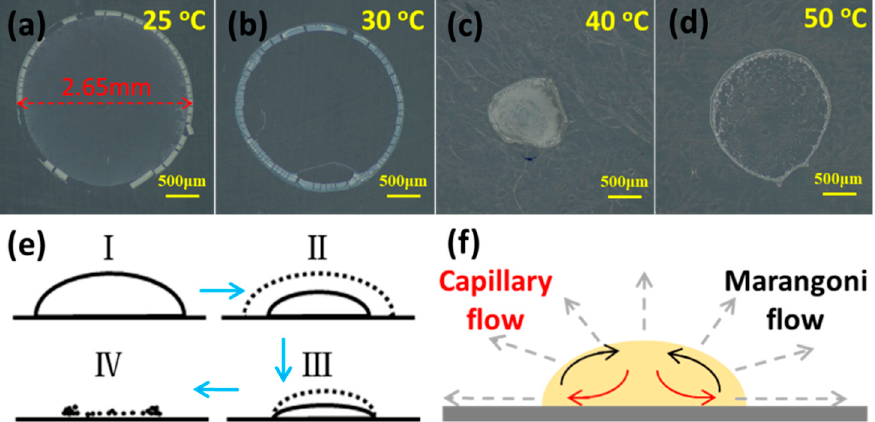
Figure 8. ( a – d ) Optical microscope observation of DEaTIPS samples at different evaporation temperature; Schematic images of ( e ) the evaporation kinetic process and ( f ) circulation flow regimes in the droplet evaporation.